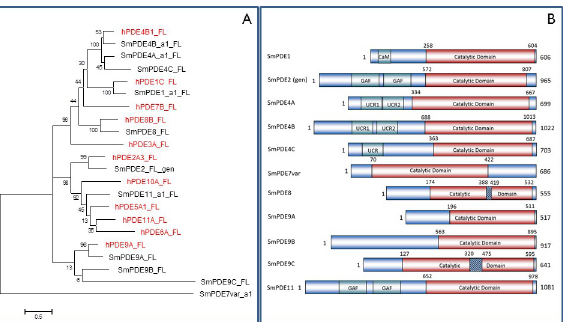
Fig 1. Overview of PDE family genes of Schistosoma mansoni . A . Phylogenetic tree comparing full length sequences of all SmPDEs to representative members of the human PDE families. Human sequences were taken from Uniprot database, the S . mansoni genes were from in-house sequencing, unless “gen” is included in the name as this gene is as listed in the S . mansoni genome (taken from WormBase ParaSite 14). Black = S . mansoni ; red = human. The tree was constructed using a ClustalW alignment [94] and the Maximum Likelihood Tree function of MEGA6, with 500 bootstrap replications, the Nearest-Neighbor-Interchange (NNI) Heuristic Method, and otherwise the default parameters. The percentage of trees in which the associated taxa clustered together is shown next to the branches. The scale bar represents the number of amino acid substitutions per position. B . Overview of domain structure of each of the S . mansoni PDE genes, using the genetic information from the successfully amplified cDNAs where available, or the genomic sequence from WormBase ParaSite 14 (for SmPDE2) where amplification from cDNA had not been successful. Significant inserts in the catalytic domain (compared to mammalian consensus sequence) are indicated by hatched areas. Start and end of the catalytic domain is indicated by amino acid numbering. FL, full